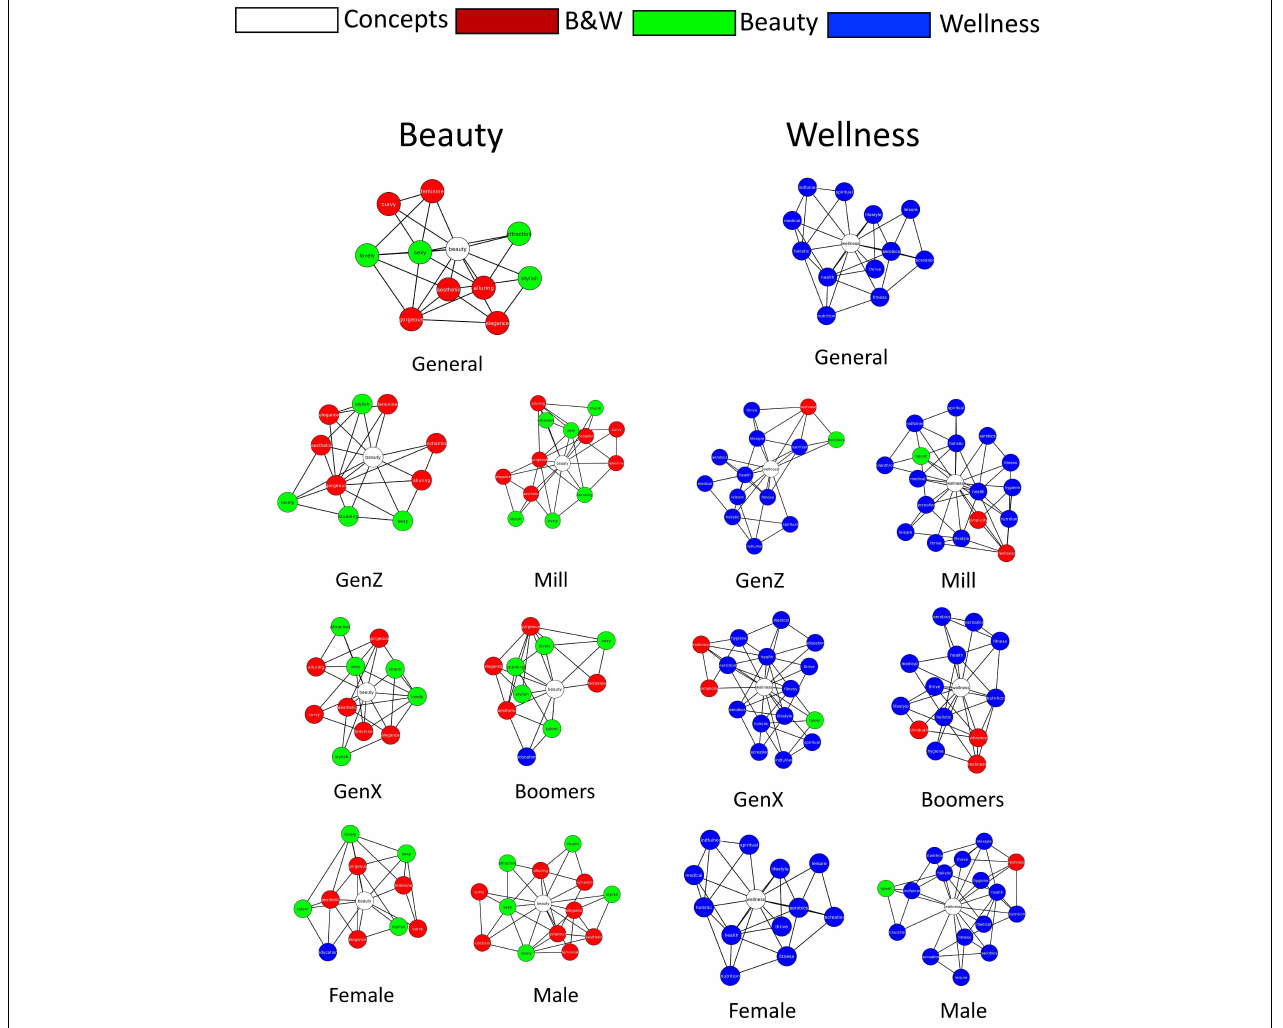
FIGURE 4 | Semantic neighbors of Beauty and Wellness across the seven estimated semantic